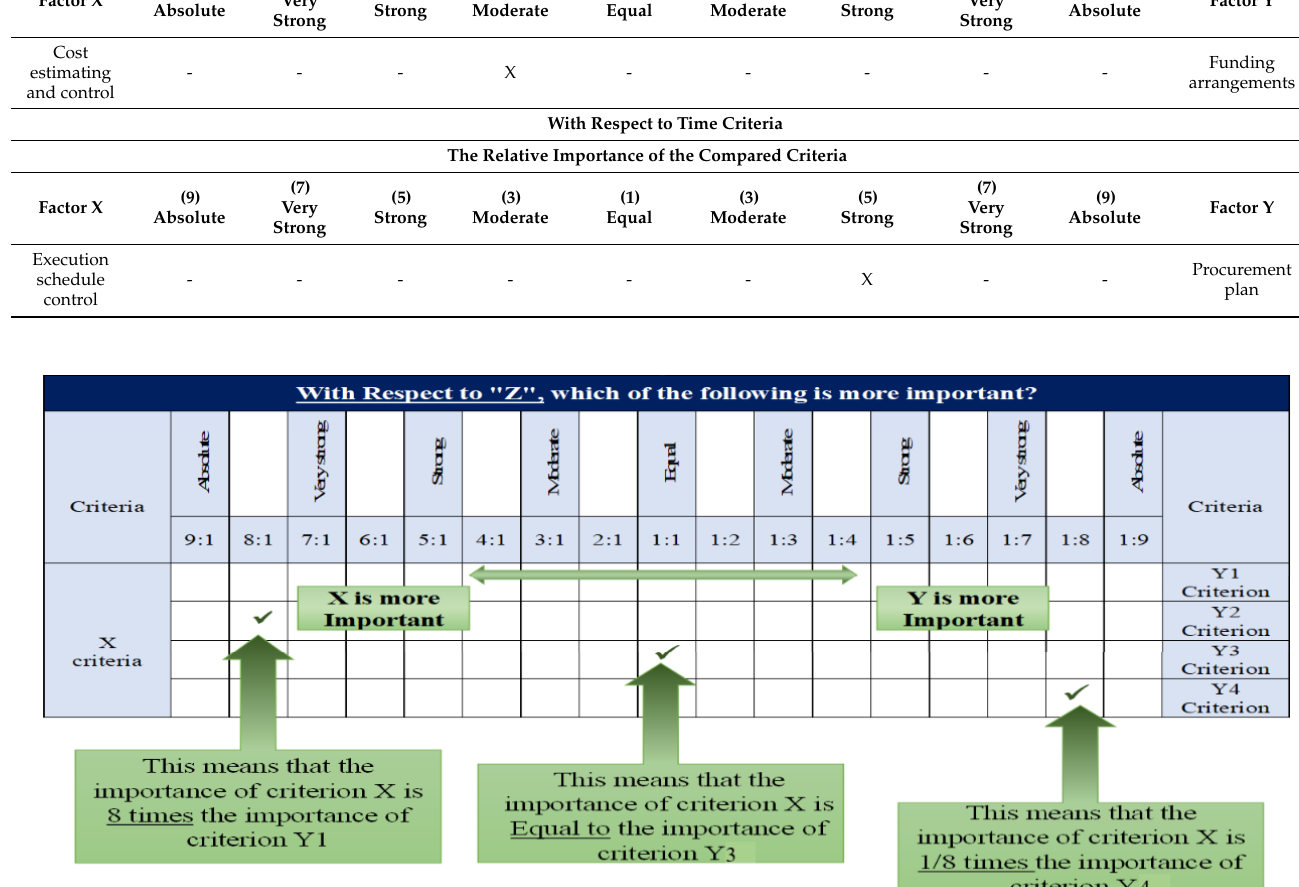
Figure 6. A sample of the assessment of different procurement methods included in the designed questionnaire . Figure 7 . Instruction provided for part 4 of the questionnaire .